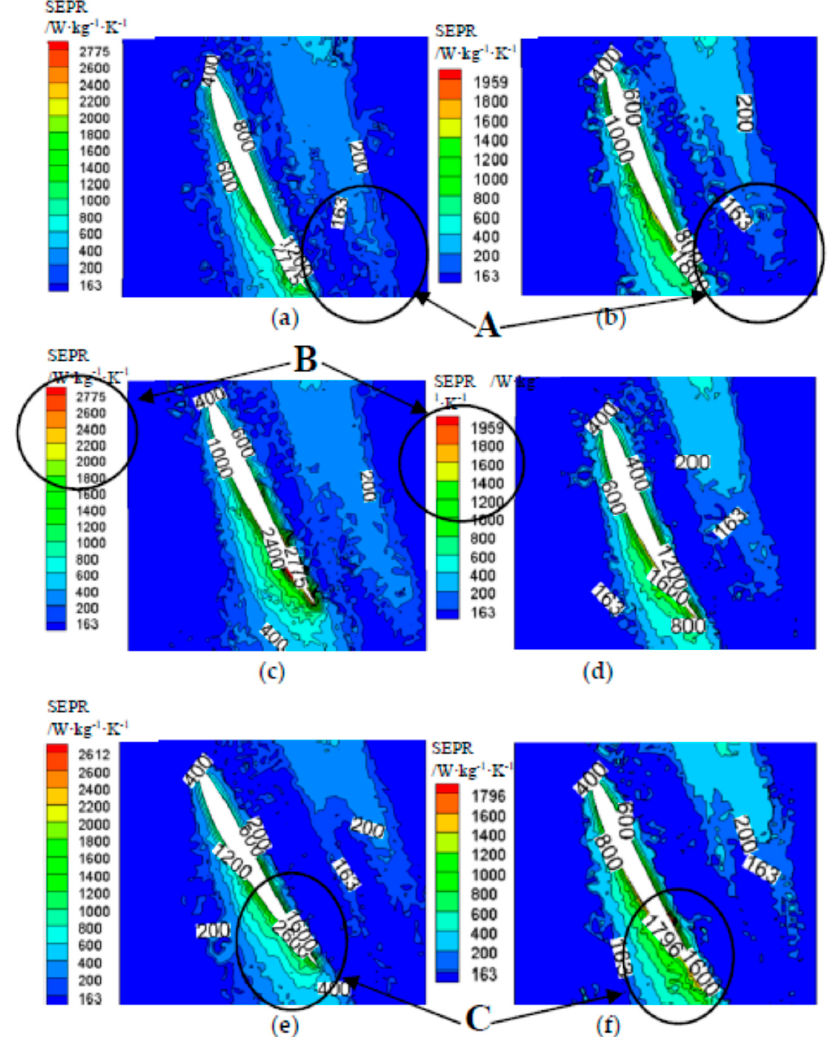
Figure 13. Specific entropy production rate (SEPR) distribution at blade tip of forward-skewed and original blades for different blade pitch angles. ( a ) β = 29°, θ = 0°; ( b ) β = 29°, θ = 3.0°; ( c ) β = 32°, θ = 0°; ( d ) β = 32°, θ = 3.0°; ( e ) β = 35°, θ =0; ( f ) β = 35°, θ = 3.0°.